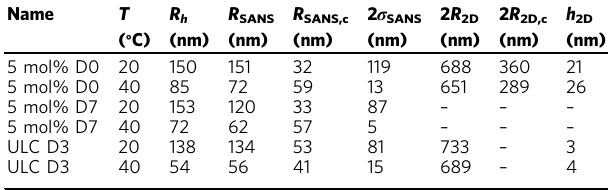
Table 1 Characteristic lengths of the individual pNIPAM- based microgels below and above their VPTT.